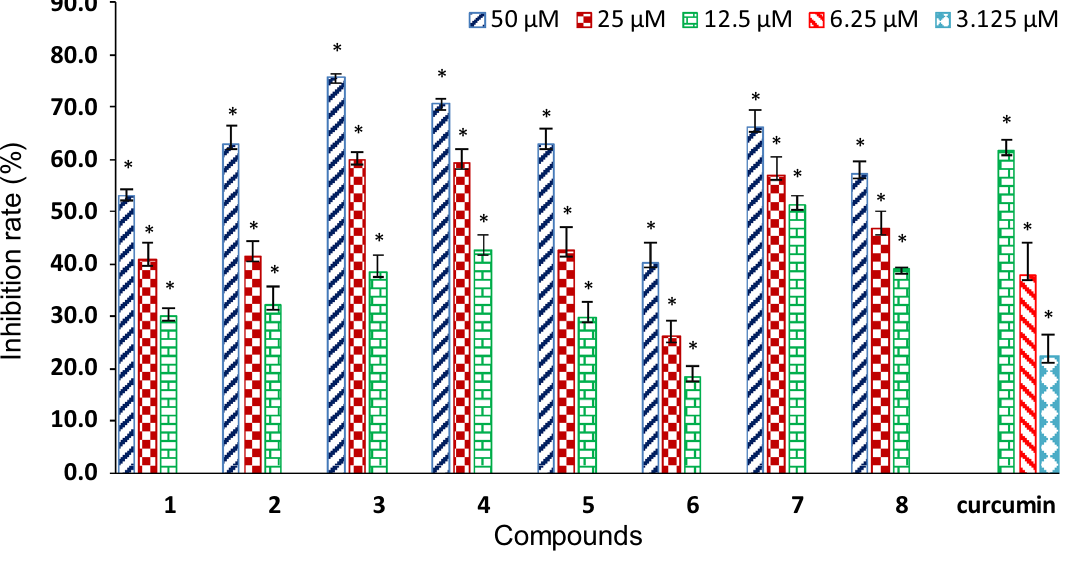
Fig. 8 Concentration-dependent inhibition of t -BHP-induced ROS production in RAW264.7 cells by compounds 1 – 8 and the positive control curcumin ( * P < 0.05 vs t -BHP